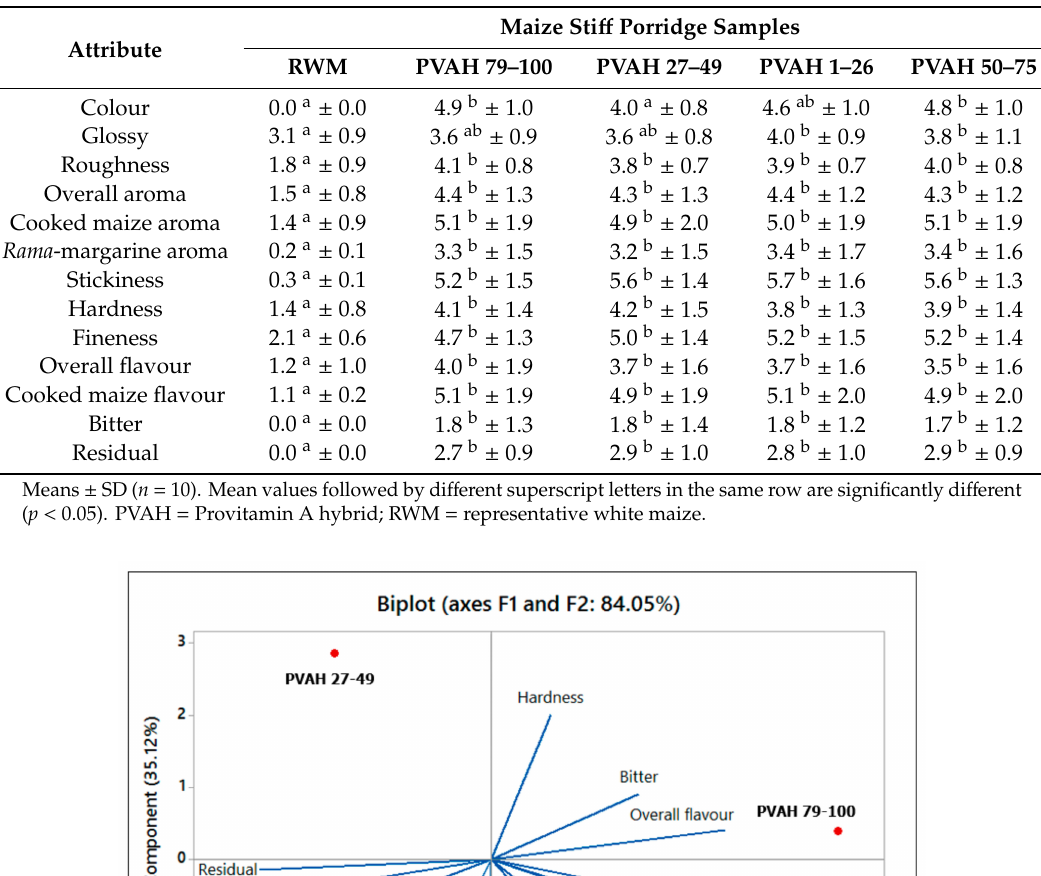
Table 4. Sensory attributes of the provitamin A-biofortified maize sti ff porridges and representative white maize porridge.